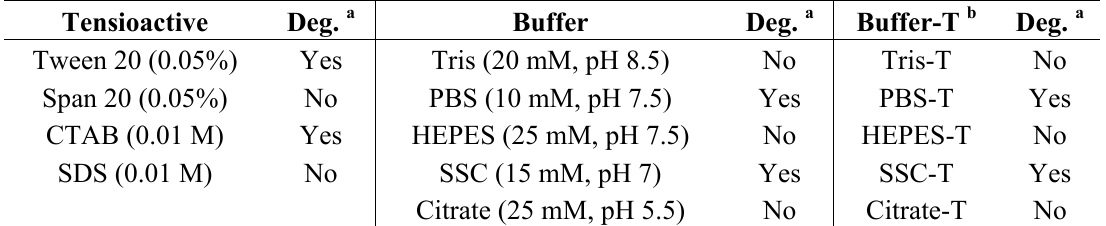
Table 1. Qualitative assessment of Al NHAs stability against different solutions. Tensioactive Deg. a Buffer Deg. a